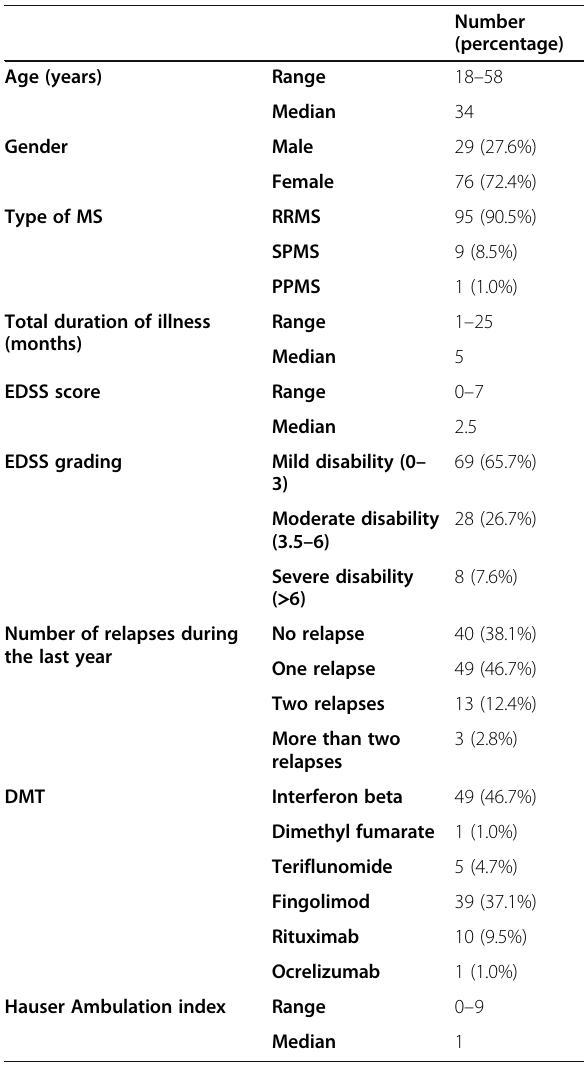
Table 2 Demographic and clinical characteristics of the study population